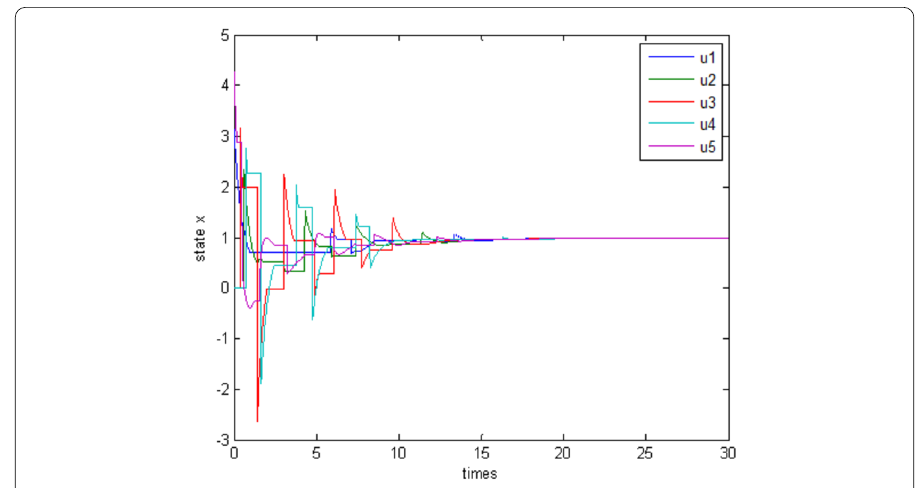
Figure 4 Input to the controller